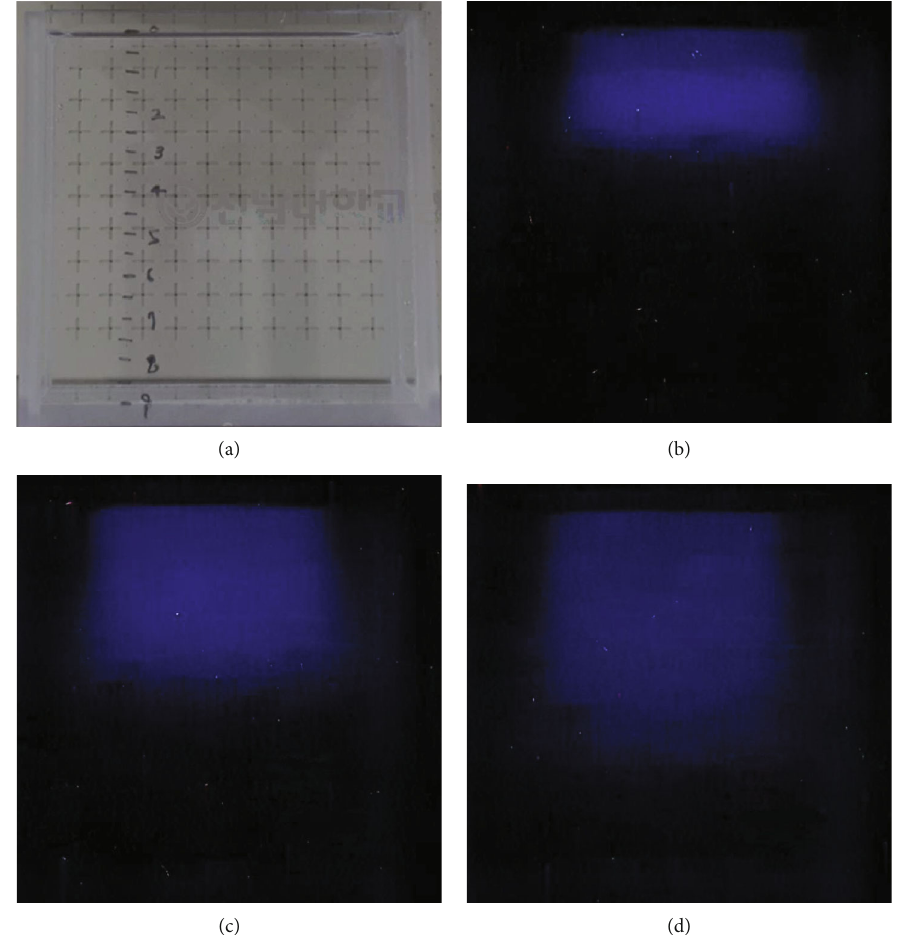
Figure 7: Range image of electron beam onto the NE3 sample: (a) acrylic container containing NE3 sample; (b) 6MeV; (c) 9MeV; (d) 12MeV. These images were taken with the camera being exposed for 5 seconds when an electron beam is irradiated onto the sample. The electron beam generated from the Varian Novalis Tx system is injected from the top to the bottom of the container. If the V value in the HSV model is greater than 20%, only those pixels are selected, and their images are used to estimate the practical range.